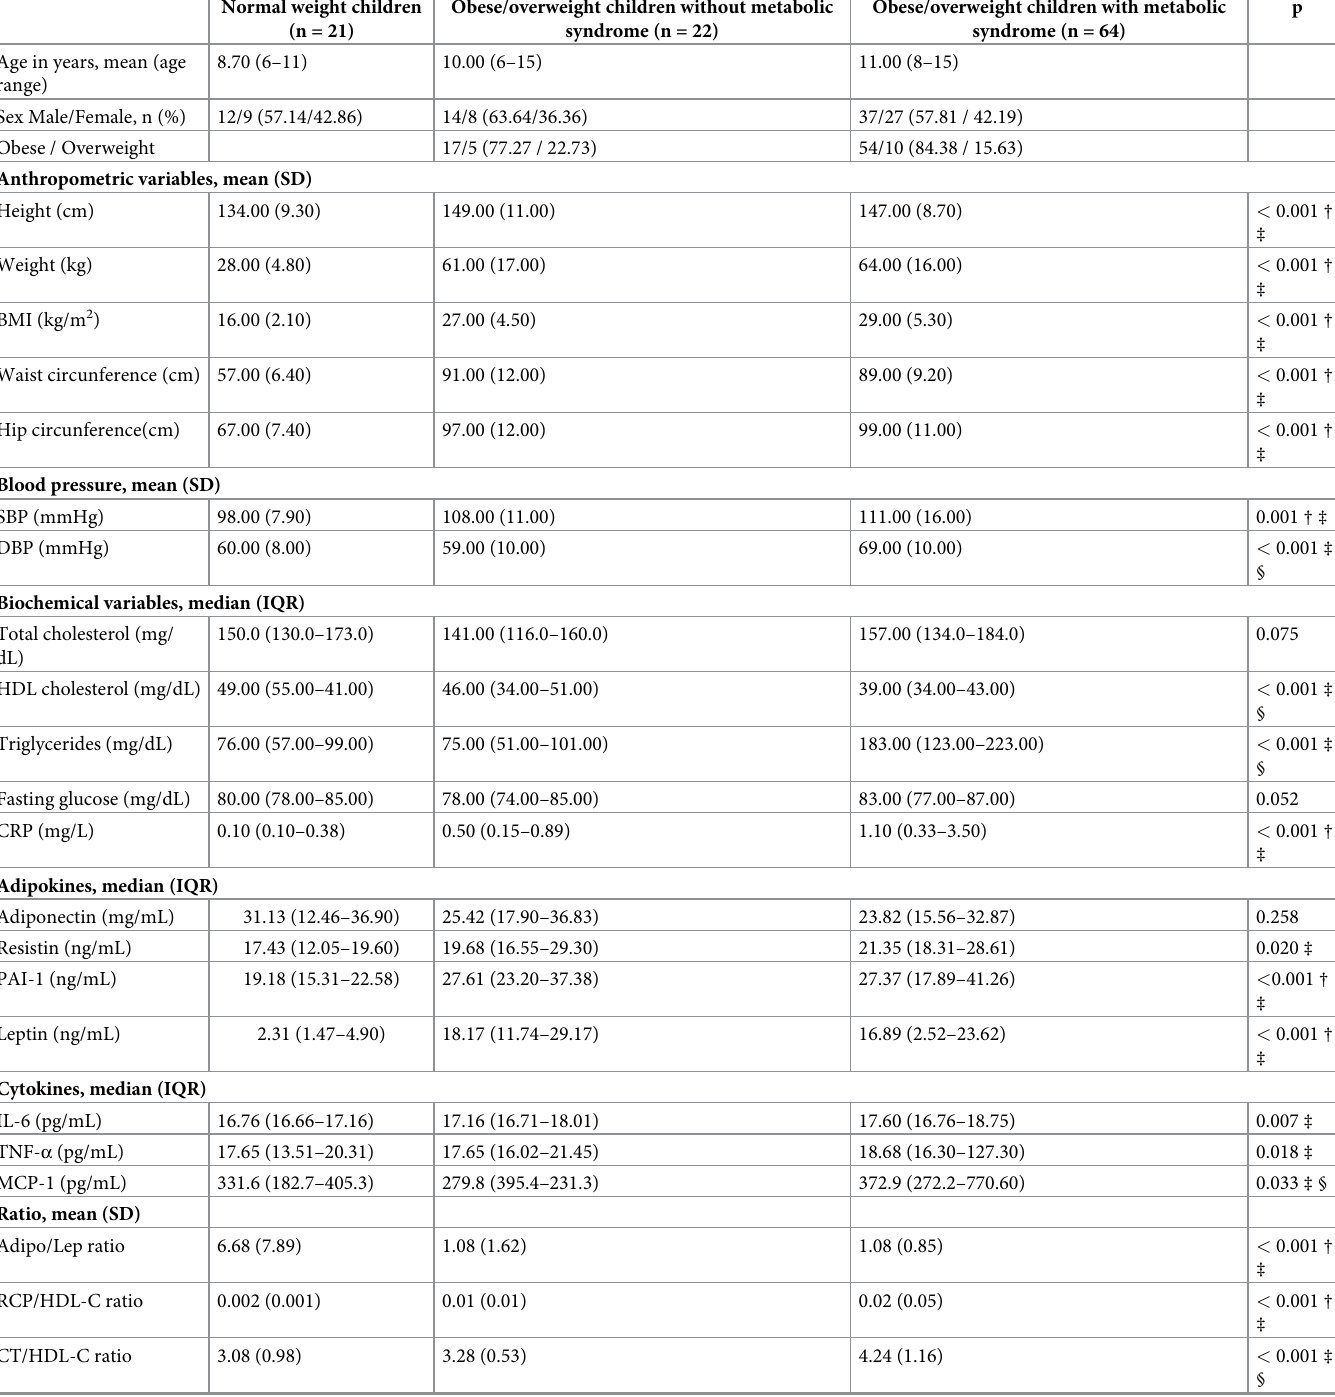
Table 1. Anthropometric and laboratory parameters of the children. Normal weight children Obese/overweight children without metabolic (n = 21) syndrome (n = 22)